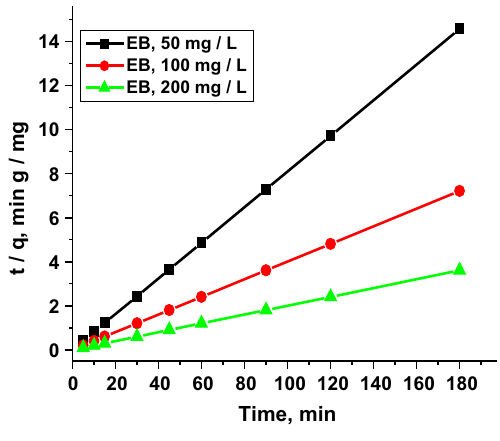
Fig. 8 Pseudo-second-order kinetic plots for Table 1 Pseudo-second-order kinetic parameters Dye conc.